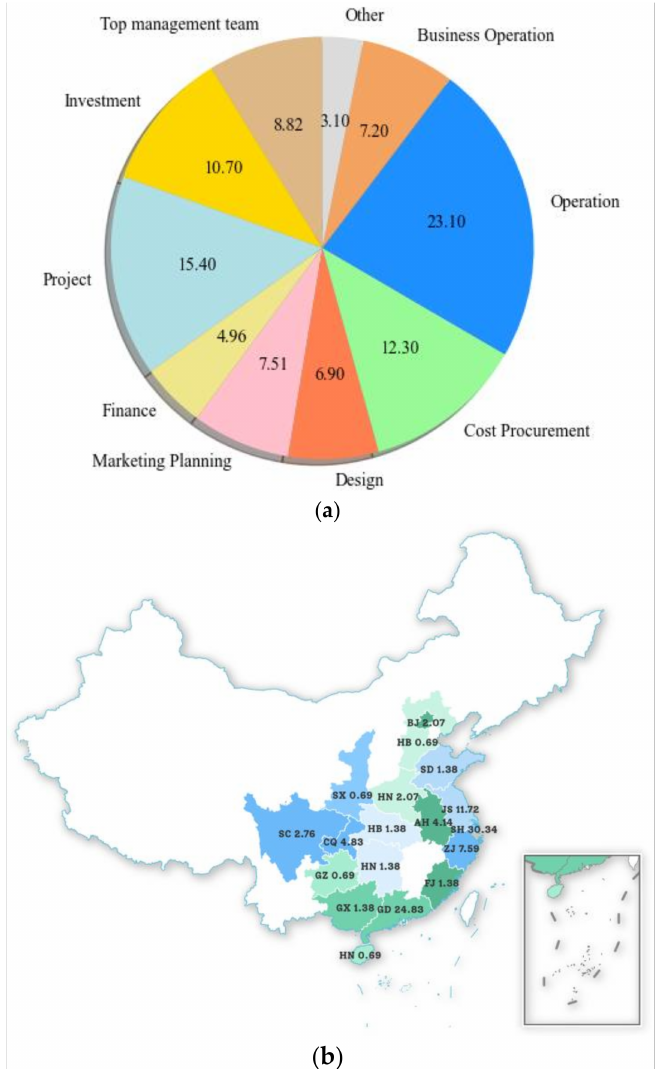
Figure 5. The demographics of the respondents. ( a ) The posts of respondents (by percent). ( b ) The regional distribution of respondents (by percent). Note: The figure is mapped based on the questionnaire